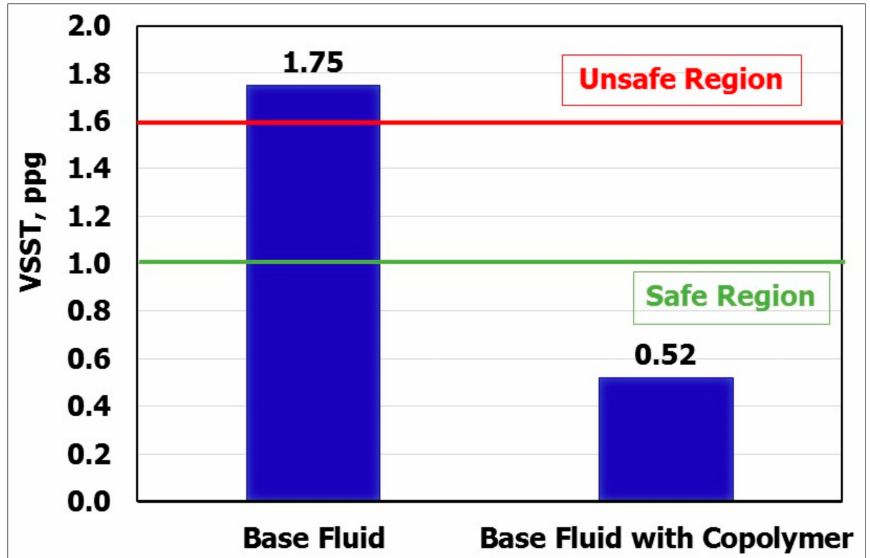
Figure 5. Dynamic sag test for the drilling fluid with and without the